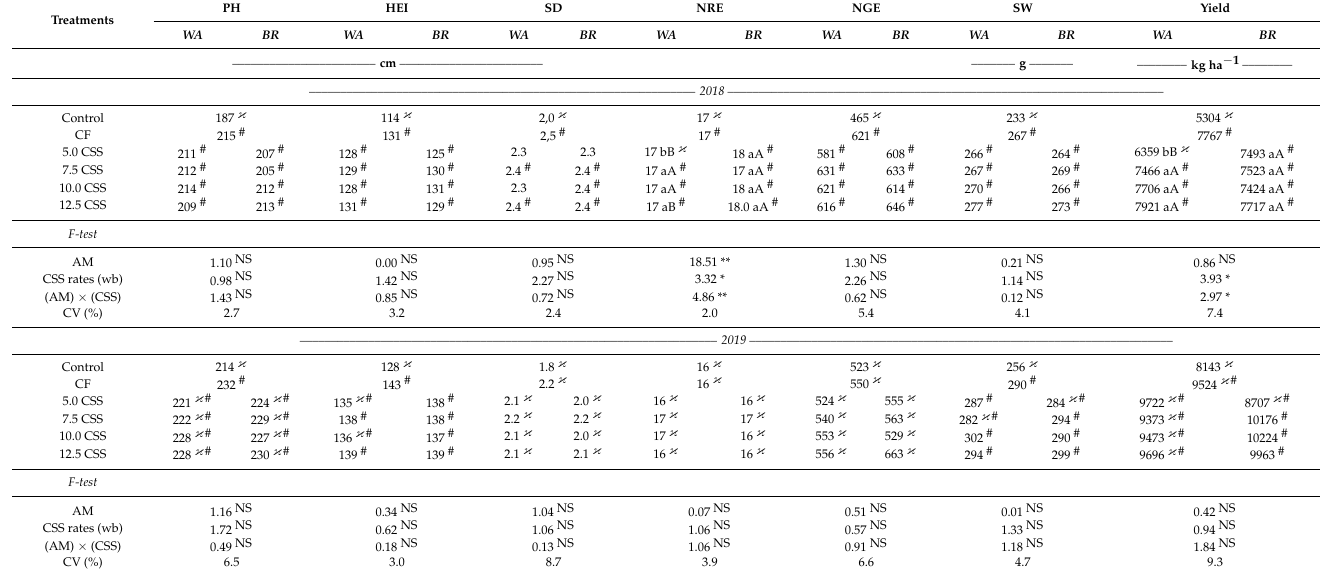
Table 3. Plant parameters and yield at the end of the investigated crop